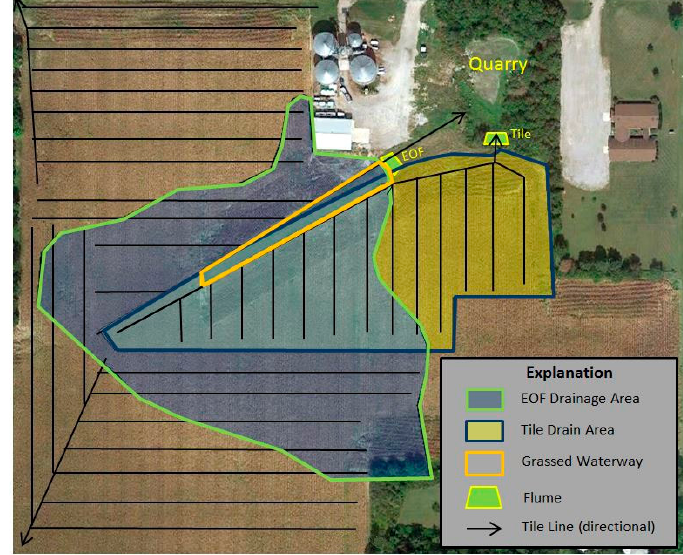
Figure 3. U.S. Geological Survey edge-of-field (EOF, subbasin 38) and tile gaging (subbasin 39) stations and drainage areas, and tile flow directions in the Eagle Creek watershed, Ohio.